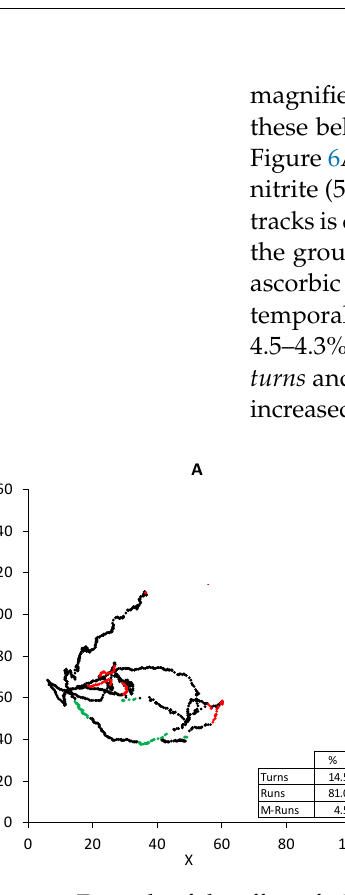
Figure 6. Example of the effect of nitrite and ascorbic acid on the real trajectories of nematodes. ( A ): AA control; ( B ): AA 3000 mg/L nitrite; ( C ): AA 5 mM ascorbic acid/3000 mg/L nitrite. Colors indicate the zones of the postural spectra corresponding to turns (red), runs (black), and M-runs (green). The legends show the % of each zone during tracking.